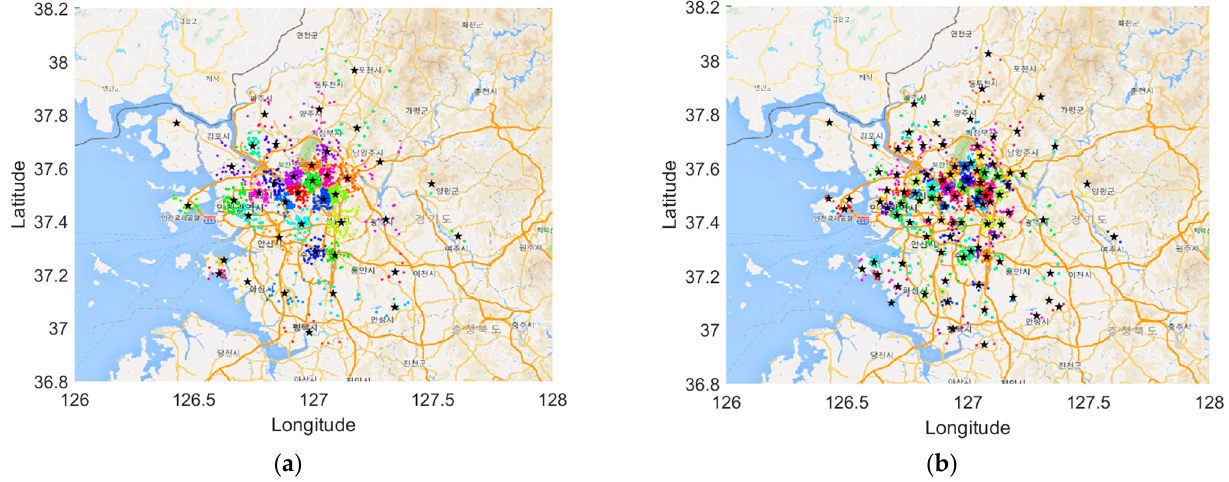
Figure 3. ( a ) Result of clustering when the number of vertiports is 40; ( b ) result of clustering when the number of vertiports is 100.